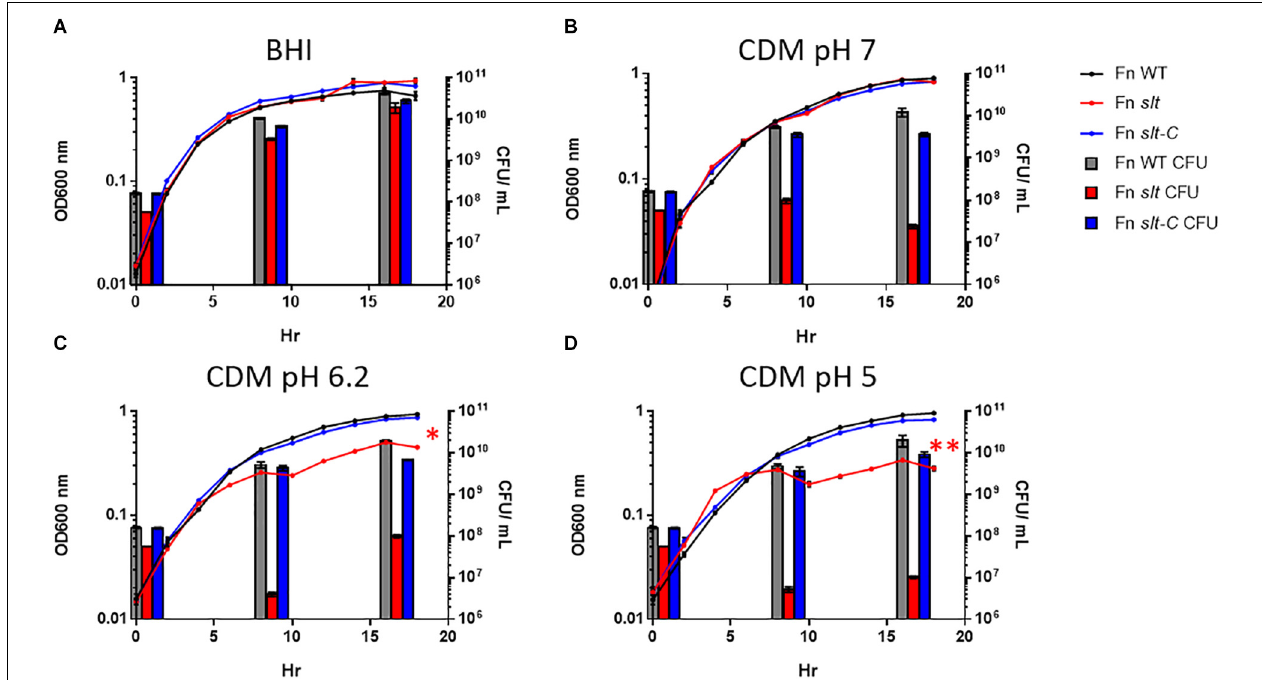
FIGURE 2 | Francisella novicida slt exhibits pH-dependent growth defects. F. novicida WT, slt , and slt -C were grown in BHI broth (A) and Chamberlain’s defined medium adjusted to pH 7 (B) , 6.2 (C) , or 5 (D) , and monitored by both optical density and plating for CFU at specific time points. OD 600 nm readings are shown as points with connecting lines, while CFU/mL at 0, 8, and 16 h growth are shown as bars. Results represent average with standard error of the mean based on quadruplicate well measurements. These data are representative of at least three experiments. CFU counts were compared using one-way ANOVA applied to log-transformed data; counts for the slt strain were significantly different from WT at 0, 8, and 16 h in all conditions tested (red bars). OD values were fitted to a logistic growth equation, and fold-change was determined by two-way ANOVA; ∗ P ≤ 0.01, slt compared to WT and slt -C, ∗∗ P ≤ 0.001, slt compared to WT and slt -C.